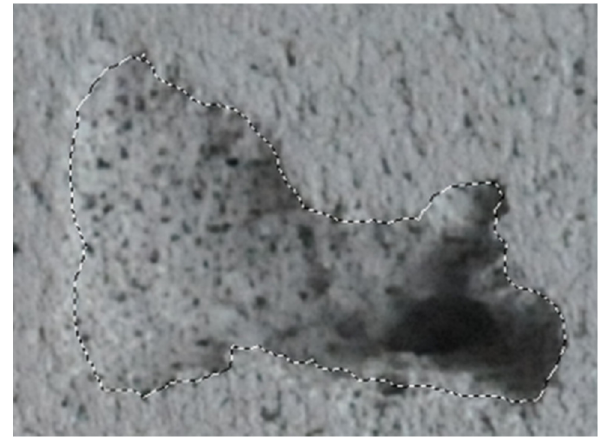
Figure 5. Measuring method of erosion area.